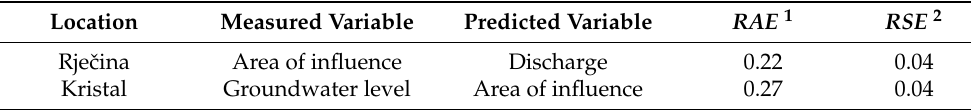
Table 6. Reliability of the